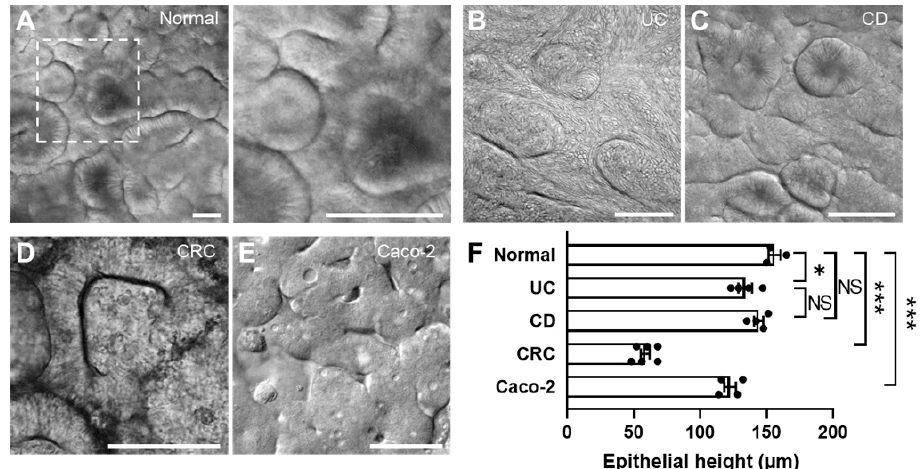
Figure 4. The regeneration of 3D epithelial morphology in a PMI Chip. The DIC micrographs reveal the 3D morphogenesis when the intestinal organoids obtained from normal ( A ) or various patient donors with UC ( B ), CD ( C ), CRC ( D ) as well as a Caco-2 epithelium ( E ) are cultured in a PMI Chip for approximately 150 h under dynamic flow (50 µL/h) and motions (5%, 0.15 Hz). A right inset in “A” is a zoomed-in view of the area indicated by a white dashed box. Bars, 100 µm. ( F ) The height of organoid-derived or Caco-2 intestinal epithelium cultured in a PMI Chip after 150 h. * P < 0.05, *** P < 0.001. NS, not significant.